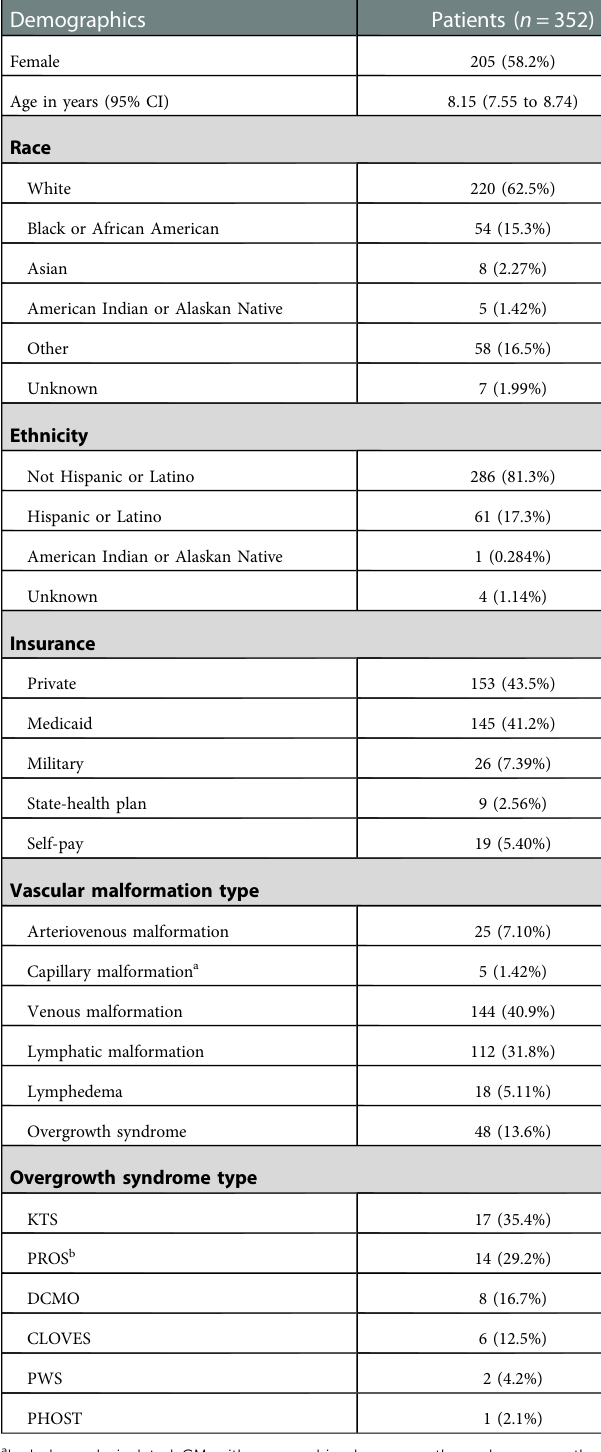
TABLE 1 Demographic characteristics and breakdown of vascular malformations.